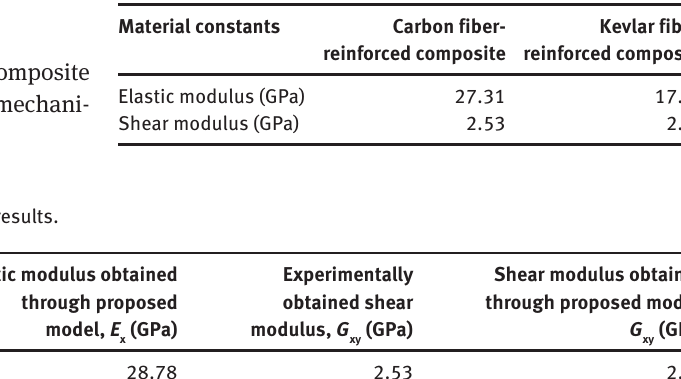
Table 6: Experimentally obtained material constants.